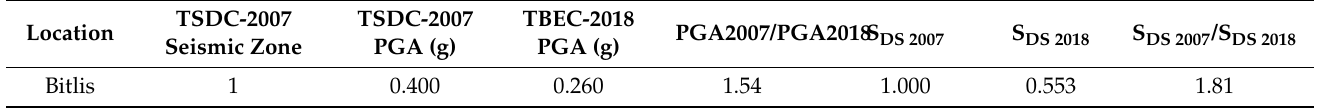
Table 5. Comparison of PGA and S DS values over the last two seismic risk